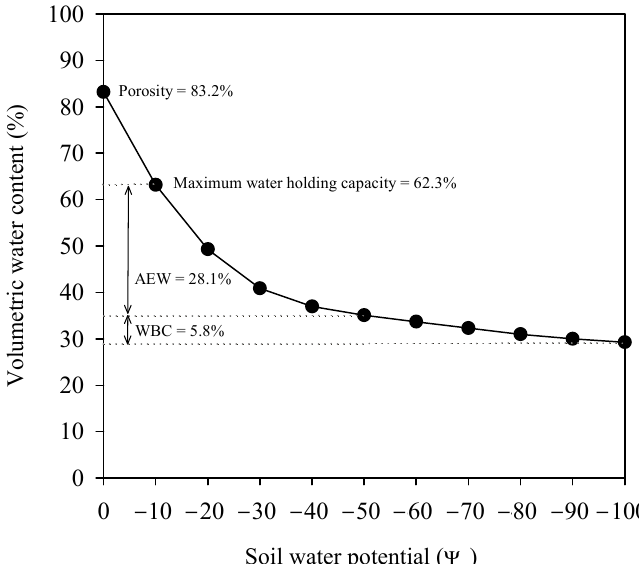
Figure 1. Water retention curve of the substrate (peat, coconut fiber, perlite (67/30/3, v / v / v )) following De Boodt’s method. The value of VWC at saturation ( Ψ w = 0) was estimated from the measurement of porosity (83.2%). EAW: easily available water, WBC: water buffer capacity.